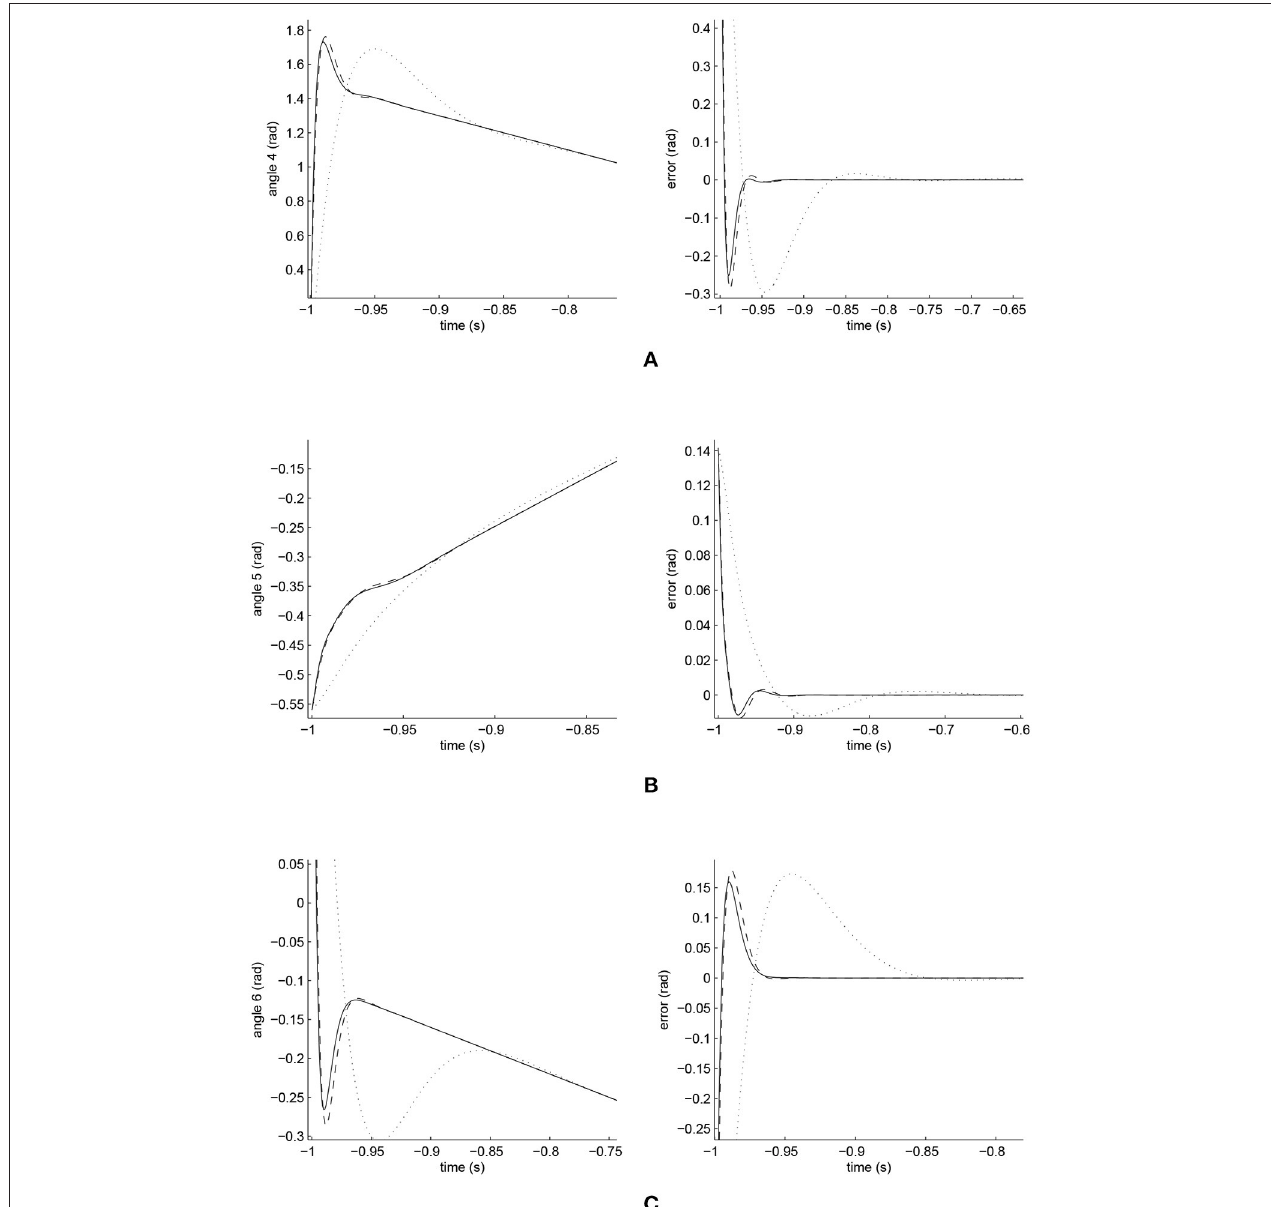
FIGURE 12 | Amplified Trajectory responses (in the left) and tracking errors (in the right) of Joints 4, 5, and 6. Solid line indicate iFBEL with the dotted one point PID controller and the dot dash one imply FCMAC controller. (A) Amplified trajectory response and tracking error of Joint 4. (B) Amplified trajectory response and tracking error of Joint 5. (C) Amplified trajectory response and tracking error of Joint